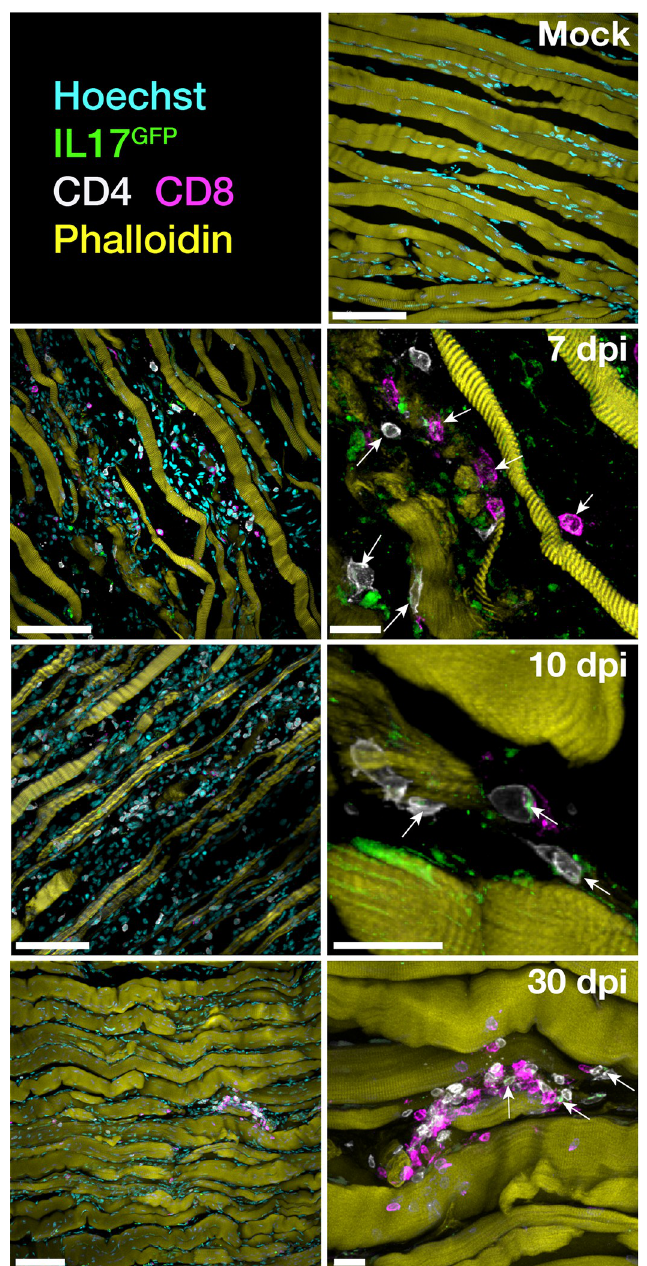
Fig 5. IL-17–producing cells infiltrate skeletal muscle during RRV disease. Immunofluorescent staining of quadriceps muscle cryosections of mock-infected or RRV-infected IL-17 GFP mice at 7, 10 and 30 dpi. Arrows indicate GFP +ve cells. Scale bars = 100 μ m (left panels) and 15 μ m (right panels). Nuclei were labelled with Hoechst 33258 and muscle fibers labelled using Phalloidin. Images representative of 3 independent experiments (n = 5 mice per group). were collected at 10 dpi. Mice treated with anti-IL-17A/F mAb showed a statistically significant reduction in disease severity compared to untreated mice, with significant reduction in clinical scores from 7 dpi to 10 dpi (Fig 6A). We next examined the effect of anti-IL-17A/F mAb on viral titers and replication in feet and quadriceps muscle. However, a significant reduction in titres was found in the feet, but not the muscle tissue, of mice treated with anti-IL-17A/F at 3